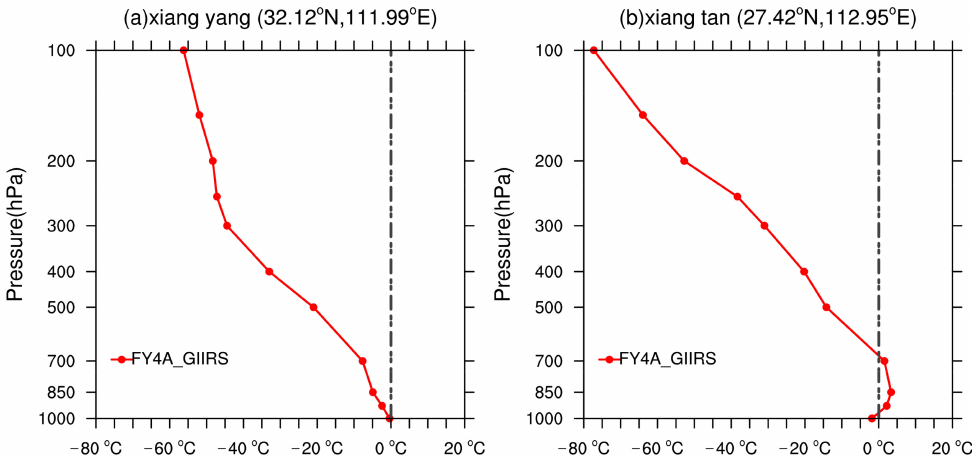
Figure 8. GIIRS temperature profiles at 08:00 (Beijing time) on 28 January 2022, in ( a ) Xiangyang, Hubei province; ( b ) Xiangtan, Hunan province. The surface observation of precipitation type was snow in Xiangyang, and the precipitation type was rain in Xiangtan at 08:00 on 28 January 2022. The quality flags of profile in Figure 8a are 3 (100 hPa), 3 (150 hPa), 0 (200 hPa), 3 (250 hPa), 3 (300 hPa), 2 (400 hPa), 1 (500 hPa), 0 (700 hPa), 1 (850 hPa), 1 (925 hPa), 0 (1000 hPa). The quality flags in Figure 8b are 0 (100 hPa), 0 (150 hPa), 0 (200 hPa), 0 (250 hPa), 0 (300 hPa), 0 (400 hPa), 0 (500 hPa), 0 (700 hPa), 0 (850 hPa), 0 (925 hPa), 1 (1000 hPa). The quality flags are 0, 1, 2 and 3, which represent perfect data, good data, bad data and very bad